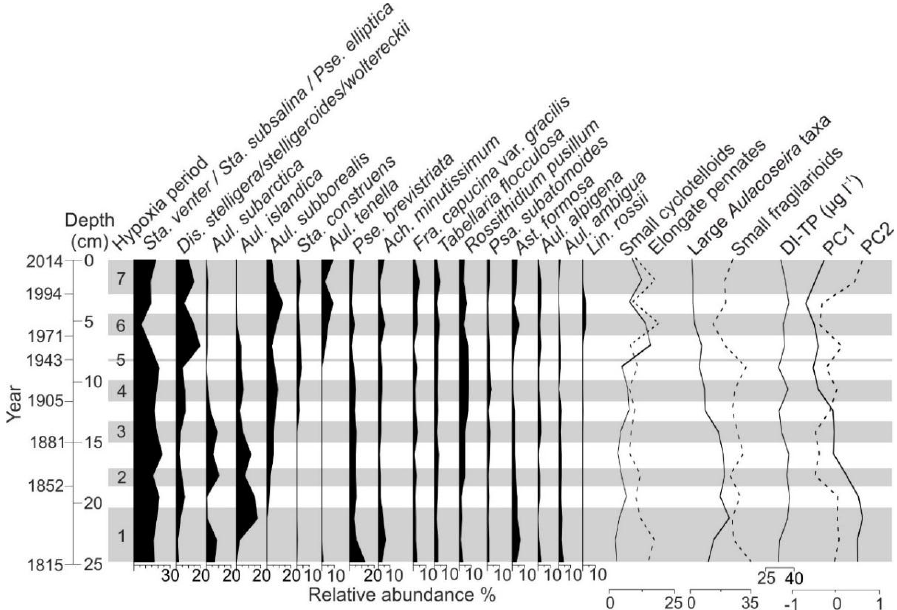
Figure 8. Relative abundances of most abundant diatom species and four higher-level taxonomic groups of core LL1. The sample scores of the first two principal components (PC1 and PC2) of diatom data and diatom-inferred total phosphorus (DI-TP), and temporal coverage of diatom samples are also shown. Hypoxia periods 1–7 are marked with grey bars. Years shown along the age/depth scale mark the onset of hypoxia periods.